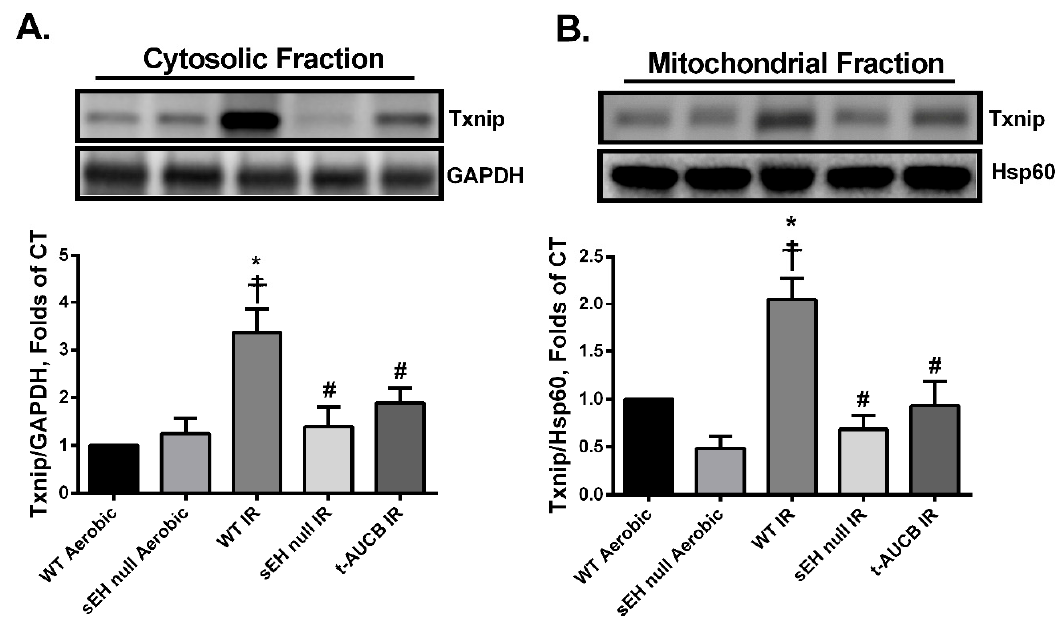
Table 1. Mitochondrial respiration was measured in permeabilized cardiac fibers freshly isolated at the end of reperfusion. Figure 5. Genetic deletion of Ephx2 or pharmacological inhibition of sEH prevented IR-induced activation and translocation of the pro-oxidant Txnip. Representative immunoblots and densiometric quantification of protein expression of ( A ) cytosolic Txnip and ( B ) mitochondrial Txnip in hearts after 30 min ischemia and 40 min reperfusion. Cytosolic protein expression was normalized to GAPDH while mitochondrial Txnip expression was normalized to Hsp60. Values represent mean ± SEM, * p < 0.05 vs. WT Aerobic CT, ☨ p < 0.05 vs. sEH null Aerobic, # p < 0.05 vs. WT IR ( n = 3 – 4 per group).